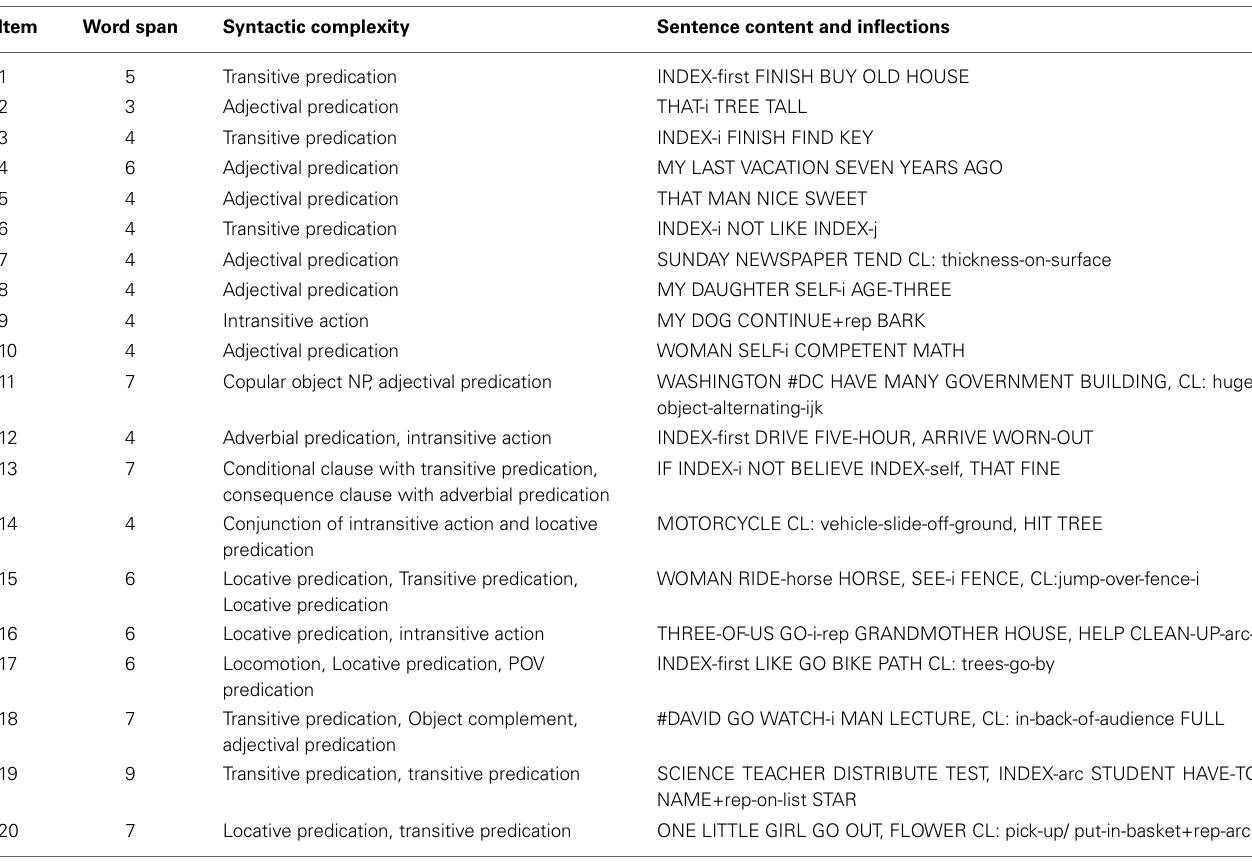
Table 1 | Word span and syntactic complexity of ASL-SRT items, with sentence content and inflections.